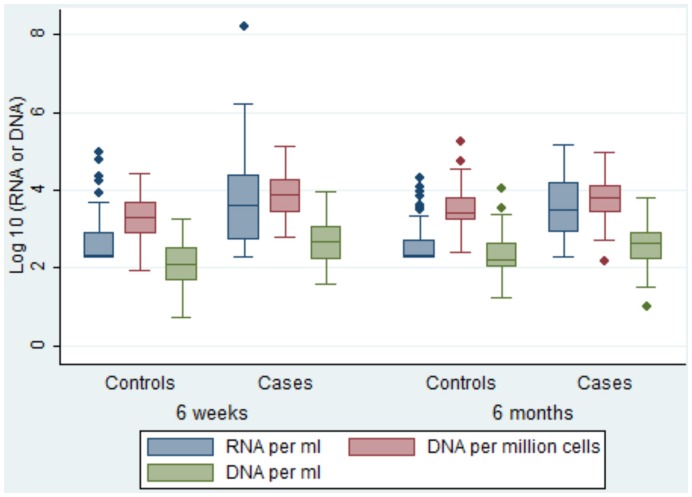
Distribution of observed log10 cell-free and cell-associated values by age of infant.